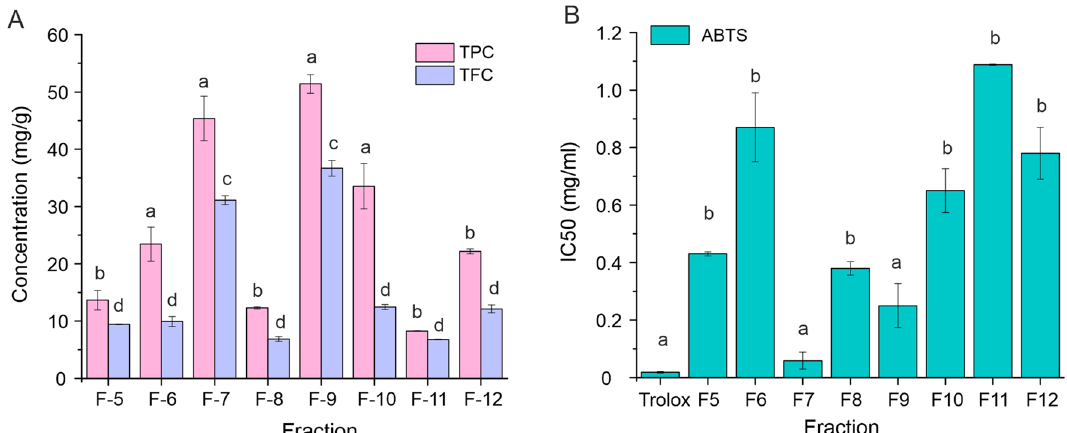
Figure 1. Phenols and flavonoids in plant extract. ( A ) Total phenolic content (TPC) and total flavonoid content (TFC) of isolated plant extracts F5–F12. ( B ) Antioxidant activities of Trolox standard and isolated plant extracts F5–F12 are shown as IC 50 values. Data are expressed as means ± S.D (n = 3). Columns indicated with the same letter are not significantly different ( p > 0.05) according to Tukey’s test.